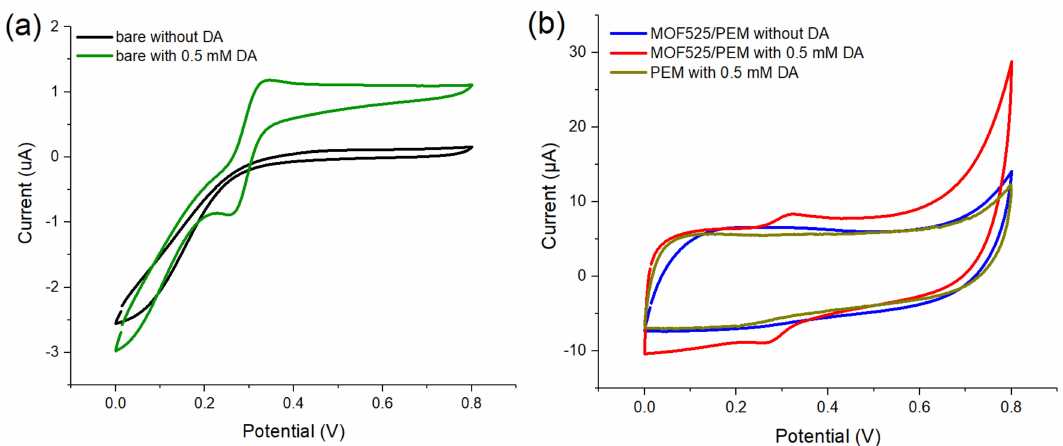
Figure 3. Cyclic voltammetry (CV) traces of ( a ) unmodified microelectrode and ( b ) modified microelectrodes in the presence of 0- or 0.5-mM DA (scan rate: 30 mV /